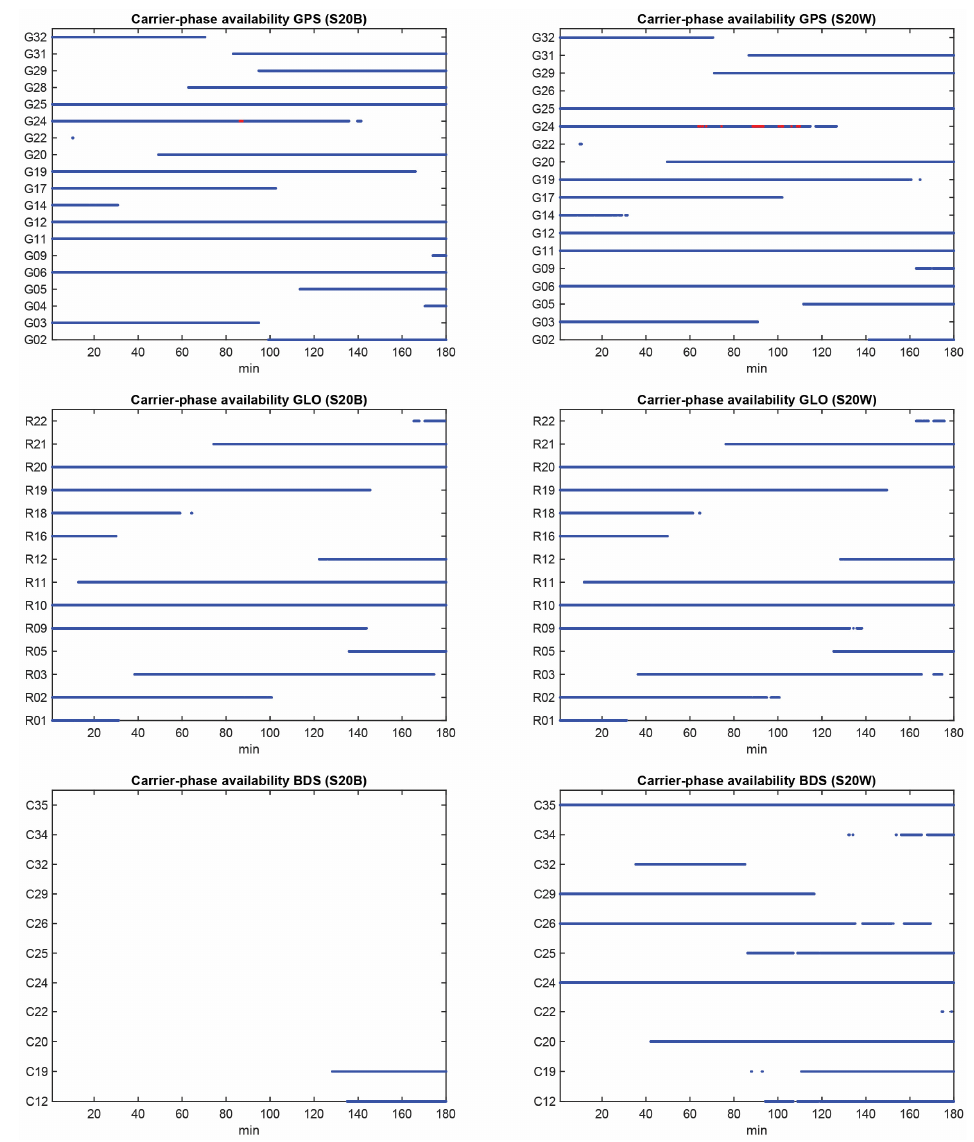
Figure 2. GPS, GLONASS, and BeiDou carrier phase continuity for S20B and S20W.